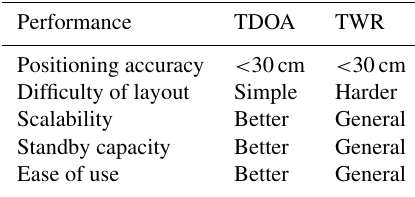
Table 2. Comparison of TDOA and